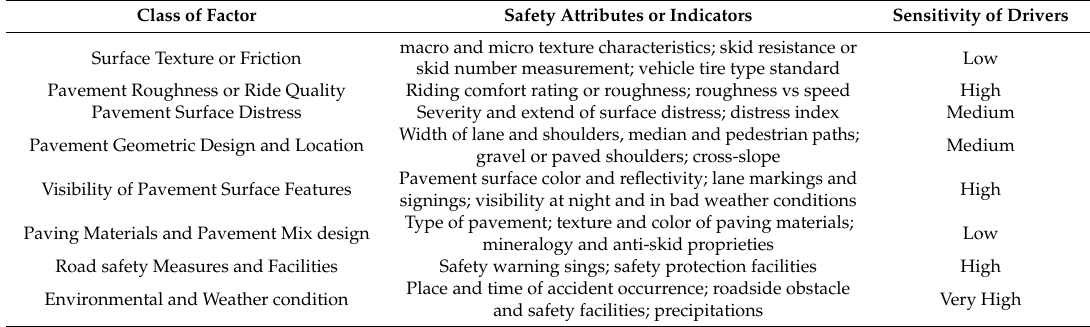
Table 2. Integration of pavement condition in a Pavement Management System (PMS)